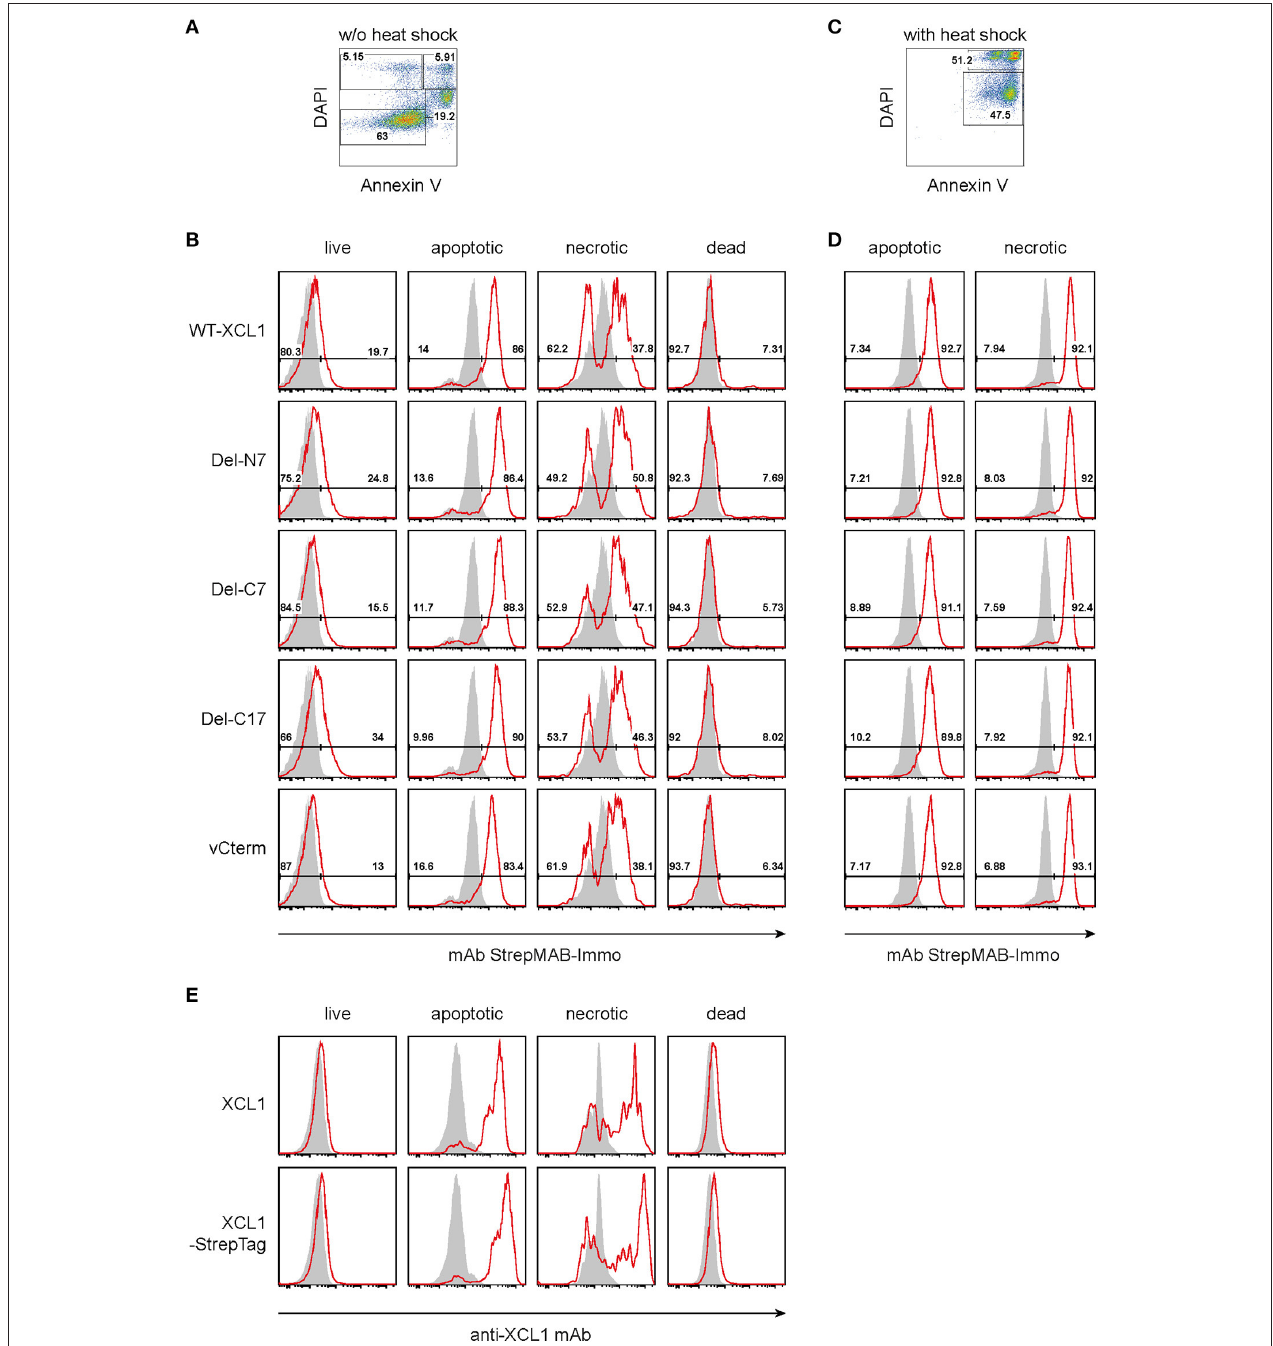
FIGURE 4 | Binding of XCL1-OVA and its variants Del-N7, Del-C7, Del-C17, and vCterm to apoptotic and necrotic cells. P3X63Ag8.653 cells were either (A,B,E) cultured at standard conditions without stress, or (C,D) subjected to thermal stress (52 ◦ C for 15min, followed by culture overnight). For the last hour of culture, 1 µ g of wt XCL1-OVA or one of its variants were added to the culture. For analysis, the cells were washed, and stained with DAPI and AnnexinV to subdivide the cells into “live” (Annexin − DAPI − ), “apoptotic” (AnnexinV + DAPI low ), “necrotic” (Annexin + DAPI + ), and “dead” (Annexin − DAPI + ) cells. (A) G ating and (B) staining of cells without thermal stress, (C) gating and (D) staining of cells after thermal stress, using anti-StrepMAB-Immo for signal detection (red histograms); background staining with StrepMAB-Immo without any preincubation is shown in gray histograms. (E) P3X63Ag8.653 cells were cultured under identical conditions, without thermal stress. For the last hour of culture, 1 µ g of wt XCL1 or XCL1-StrepTag were added to the culture. Washing of cells and gating with DAPI and AnnexinV was as described above. Signal was detected with mAb MTAC-311 specific for murine XCL1 (red histograms), background signals with MTAC-311, without any preincubation, are shown in gray. Concentrations of XLC1-variants are based on the XCL1-component of the respective construct.